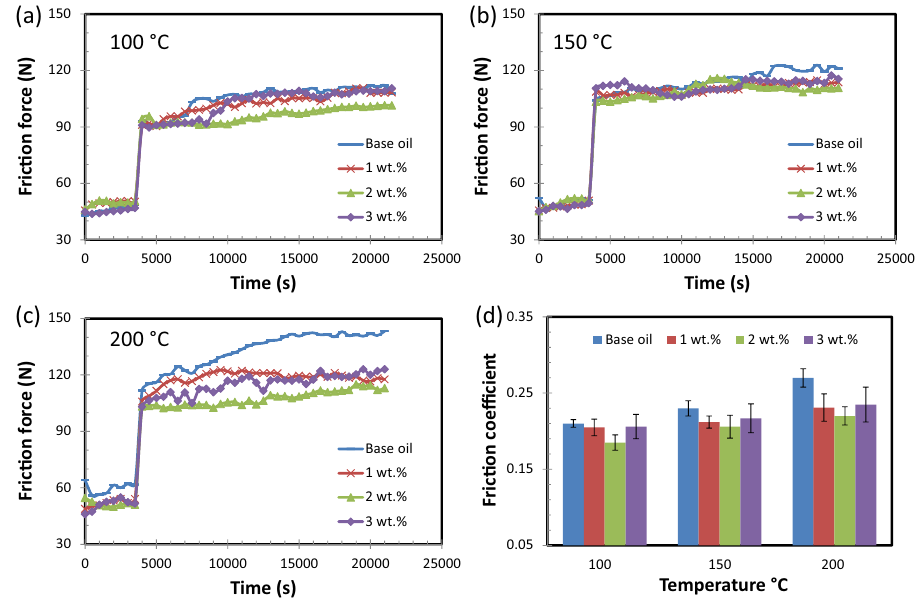
Figure 7: The typical friction force variation of the nitriding liner and the PVD - CrN piston ring in wear tests lubricated with di ff erent PANi/ND content: ( a ) 100°C, ( b ) 150°C, ( c ) 200°C and ( d ) summarized friction coe ffi